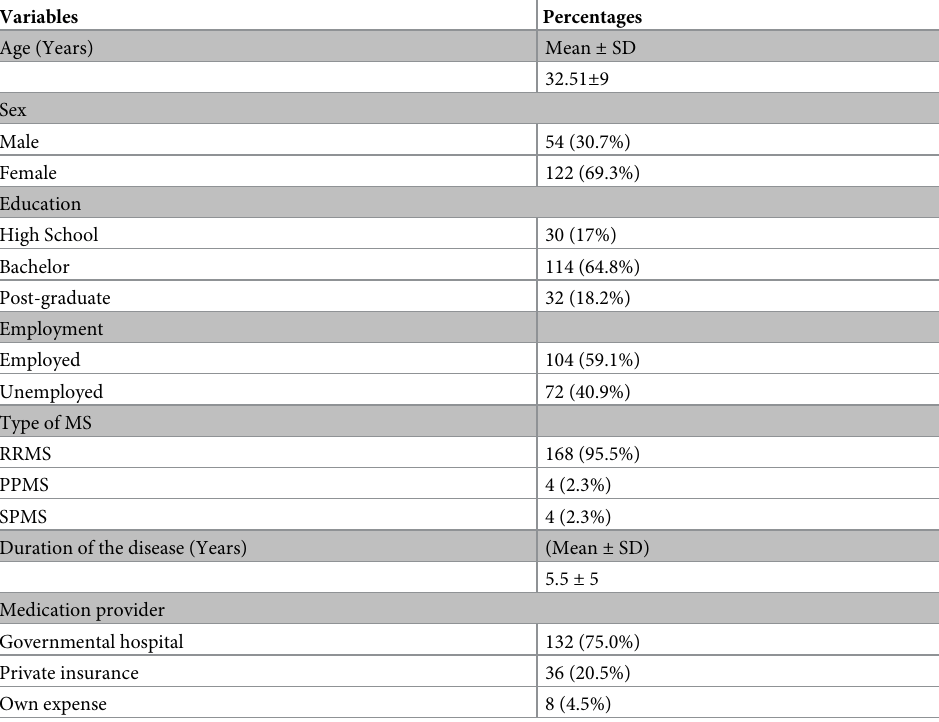
Table 1. Demographic and other various characteristics of